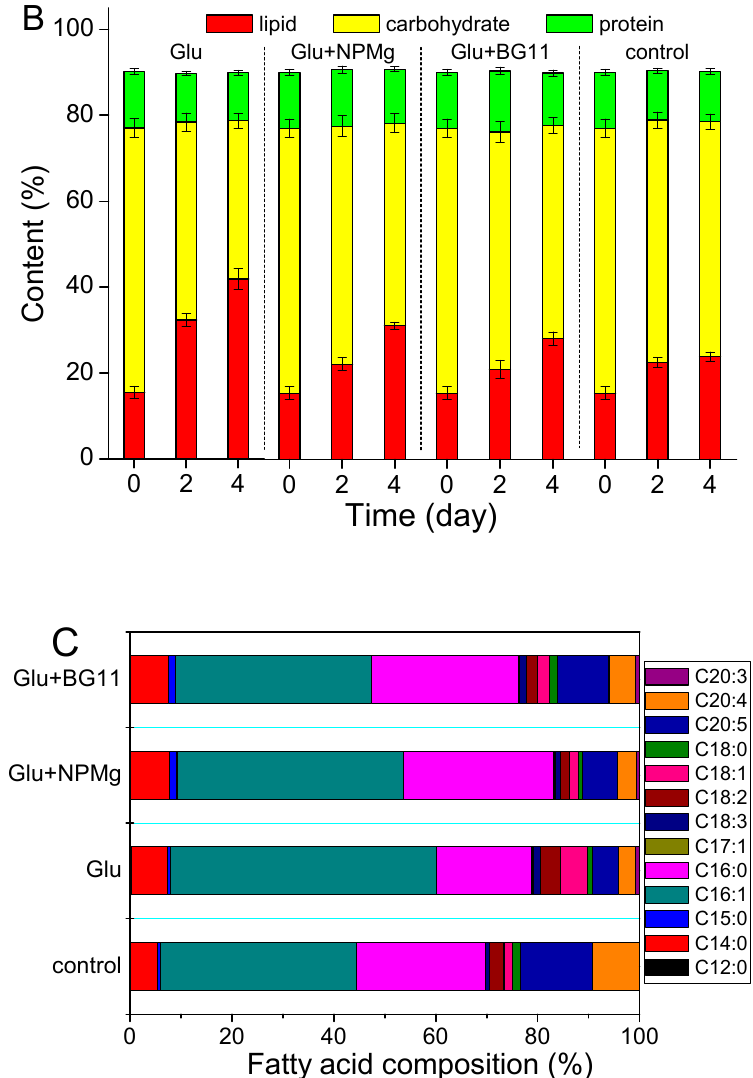
Figure 2. Growth curve and glucose consumption ( A ), cellular components ( B ) and fatty acid profiles ( C ) of T. minus in different mediums under heterotrophic regime. Values shown are averages of three replicates and error bars represent the standard deviations for the replicates.